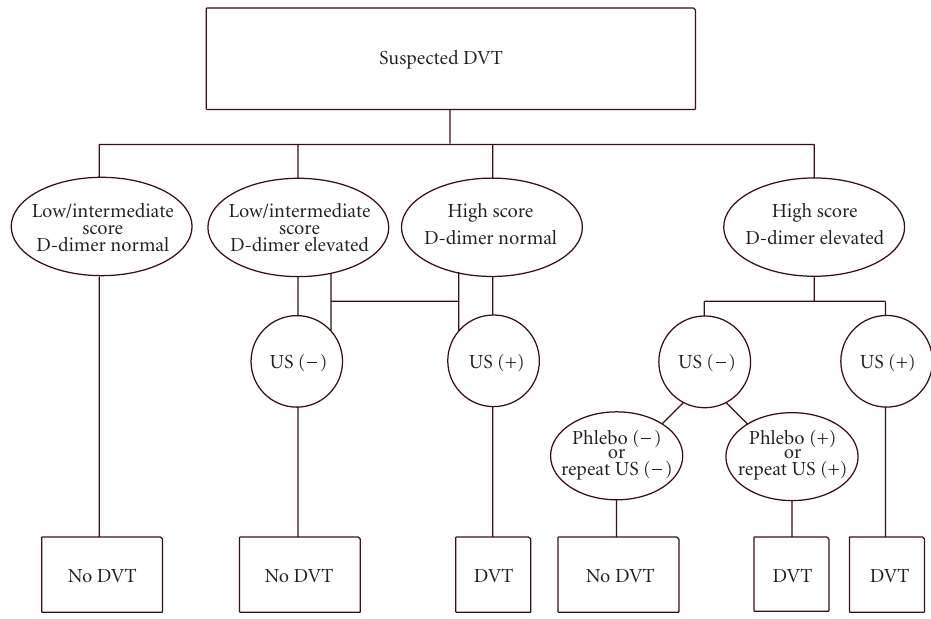
Figure 4: Algorithm for the diagnosis of DVT in symptomatic patients. By applying a diagnostic strategy based on the clinical score and D-dimer test; venous USD is performed in patients with a high clinical score, an elevated D-dimer, or both. The appropriate examination is compression color duplex ultrasound of the complete venous system, including the distal veins, when focal symptoms or physical findings are present and bilateral examination in the high-risk patient. Contrast venography is reserved for a minority of cases. Modified from Mantoni M. Ultrasound of limb veins. Eur Radio 11 : 1557-62, 2001 (with author’s